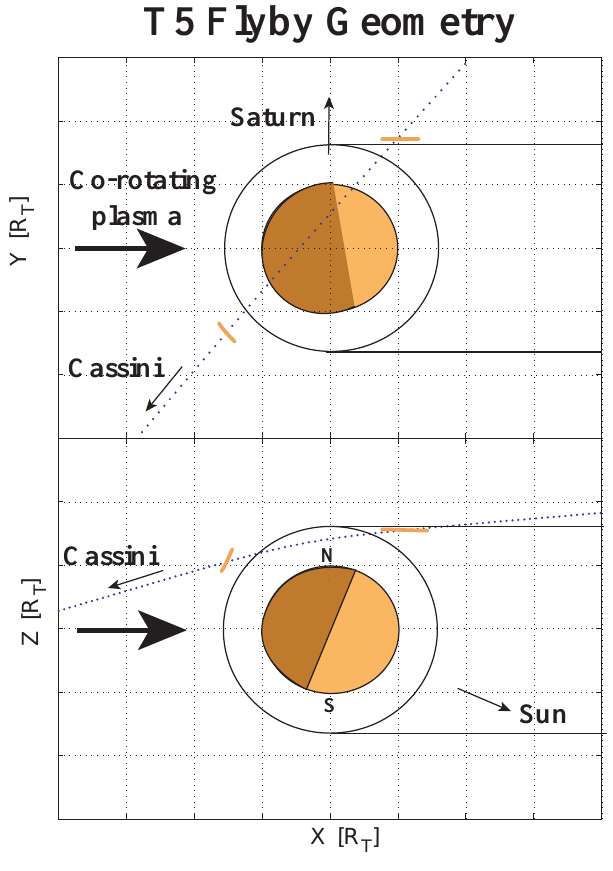
Fig. 1. Geometry of Cassini’s Titan T5 Flyby, 16 April, 2005, with the spacecraft trajectory. Saturn ecliptic coordinates ( X in co- rotation direction, Y is toward Saturn, Z is Saturn north). Each blue point represents one minute of flight. The circle around Ti- tan represents the exobase at 1430km. The RPWS detected cold plasma of ionospheric origin out to heights about 2200km inbound and 2500km outbound (orange